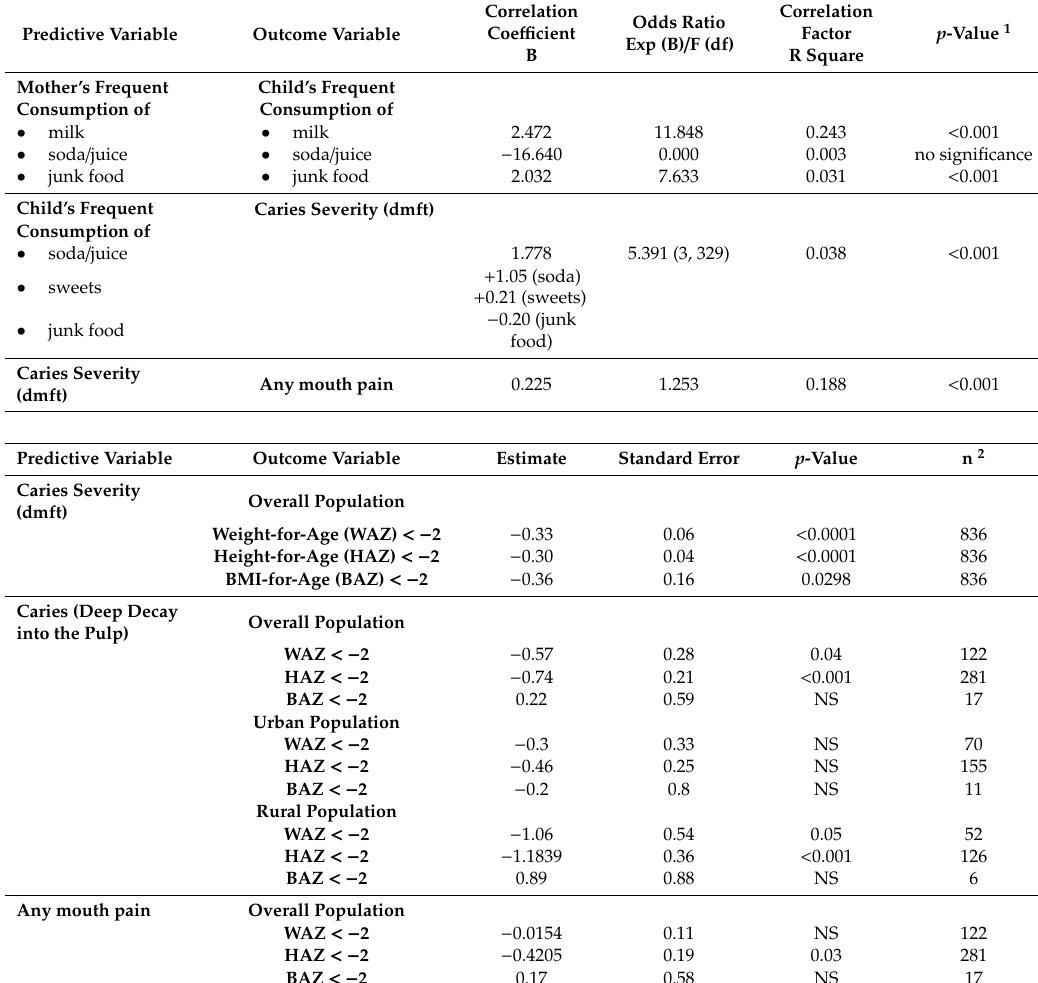
Table 4. Associations between oral health and